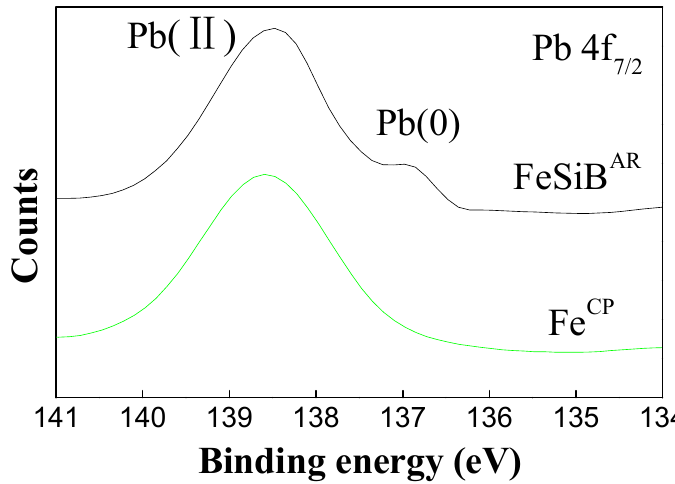
Figure 6. Pb 4f 7/2 spectra of the reacted FeSiB AR and Fe CP . Figure 6. Pb 4f spectra of the reacted FeSiB AR and Fe CP . 7/2 Furthermore, the XPS spectra of FeSiB AR before and after reaction are compared in Figure 7. The surface of the as-received FeSiB AR was surrounded by oxide and hydroxide of iron, silicon oxide, and boron oxide. However, the XPS peak of O 1s disappeared after Ar + sputtered at 0.4 nm/s for 20 s, suggesting that the thickness of the oxidation layer on the surface of the FeSiB AR produced in the atmosphere is about 8 nm. Furthermore, compared with the nominal composition of Fe 78 Si 9 B 13 amorphous ribbon, the atomic ratios of Fe:Si:B on the surface of the as-received FeSiB AR is 47:37:16, indicating that Si and B atoms are enriched on the surface due to a lower binding energy and the larger diffusion coefficient of Si and B elements [25]. The enrichment of Si and B element may leave an